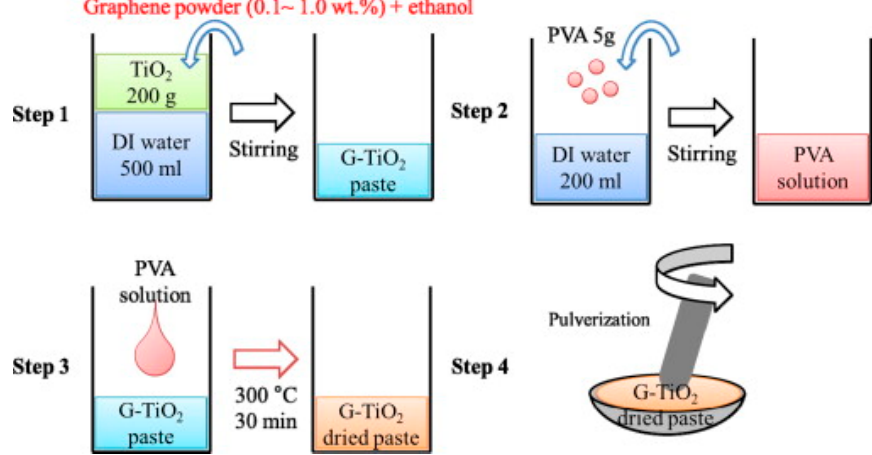
Figure 9. Scheme employed to prepare TiO 2 /G powder for the AD experiment. Reprinted with permission from reference [144]. Copyright 2014 Elsevier.